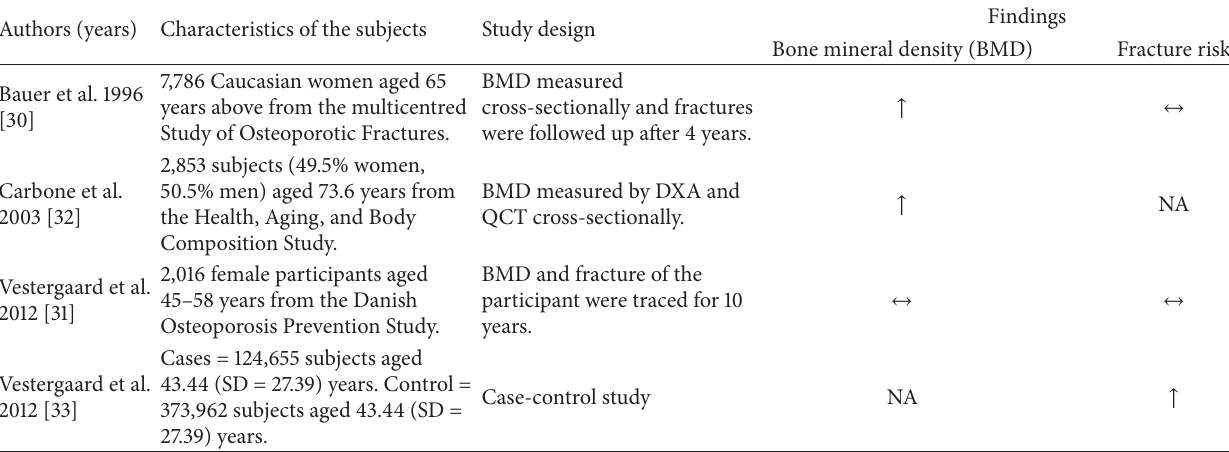
Table 2: The association between aspirin use and bone mineral density and fracture